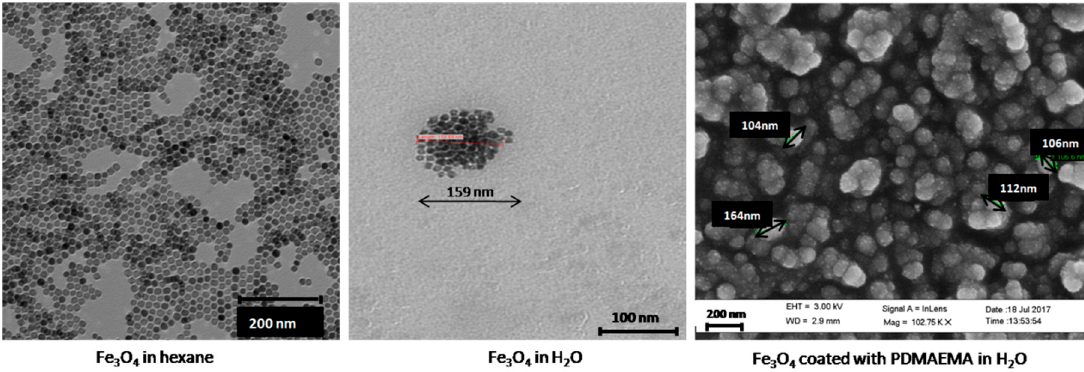
Figure 1. Transmission electron microscopy (TEM) images of Fe 3 O 4 nanoparticles in hexane ( left ), and water ( center ) before coating. Scanning electron microscopy (SEM) picture after coating with poly(2-(dimethylamino)ethyl methacrylate) (PDMAEMA) ( right ).